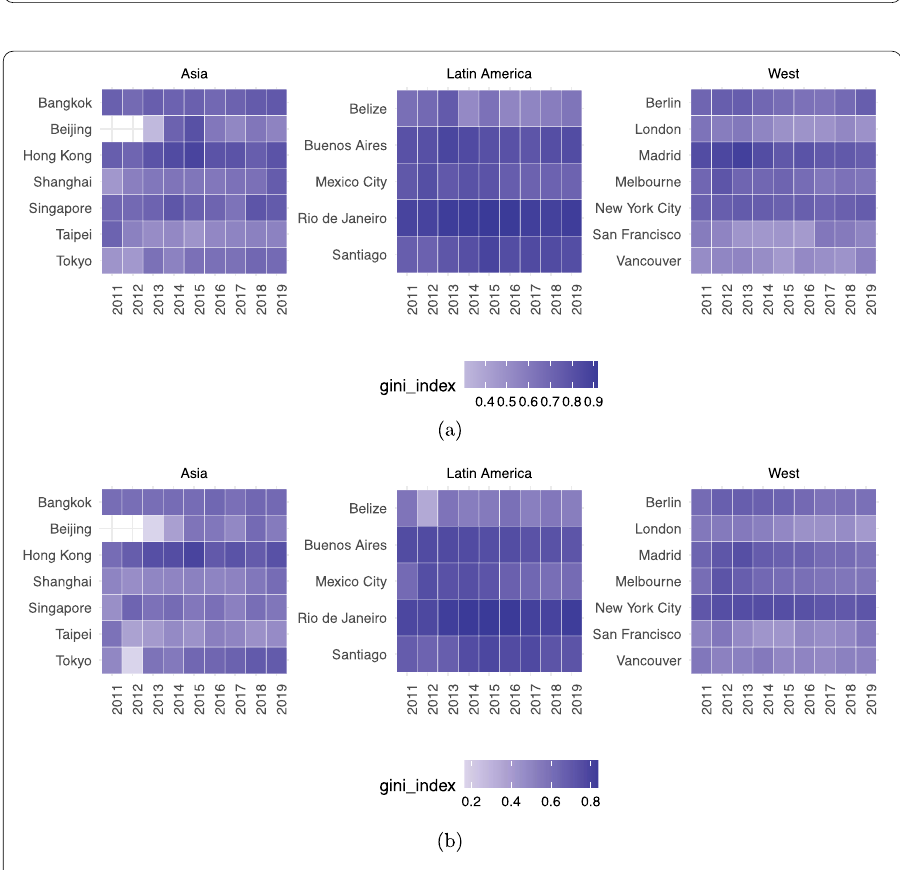
Figure 4 Guest inequality measured as Gini coefficient of the number of reviews per area